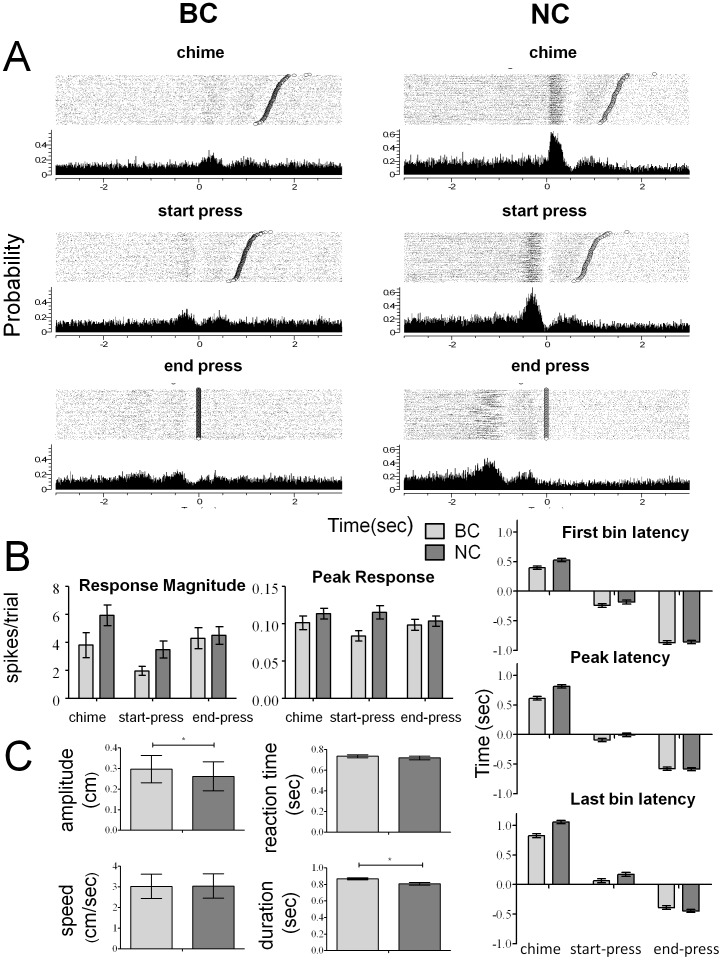
Single neuron activity during pedal press.(A) Peri-event time histograms (PETHs) and spike rasters for a representative neuron aligned to different events (chime, start-press, end-press) during the task for BC (left panel) and NC (right panel) mode. The y-axis represents the probability of a spike occurring in a bin of size 5 ms, x-axis represents the time from the event around which the PETH is centered in seconds. Trials are sorted by the duration of the press as measured from the reference event. Open circles in the rasters mark the end of press. (B) Differences in neurophysiological parameters (left panel-response magnitude, peak response; right panel- response latencies) between NC and BC mode. See Methods for description of parameters. (C) Differences in the four kinematic parameters between modes: behavioral control (BC) and neural control (NC). Asterisks indicate a significant difference.